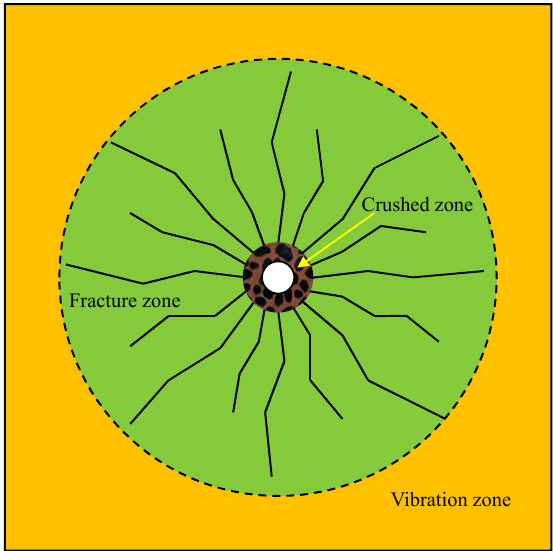
Figure 2. Diagram of cylindrical charge blasting.